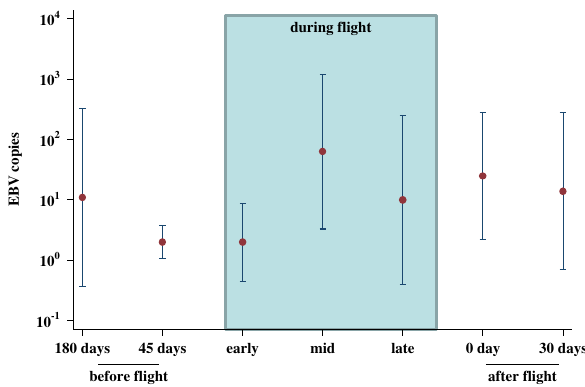
Fig. 3 Median Levels of EBV DNA (with 95% con fi dence limits) in peripheral blood mononuclear cells (PBMCs) before, during, and